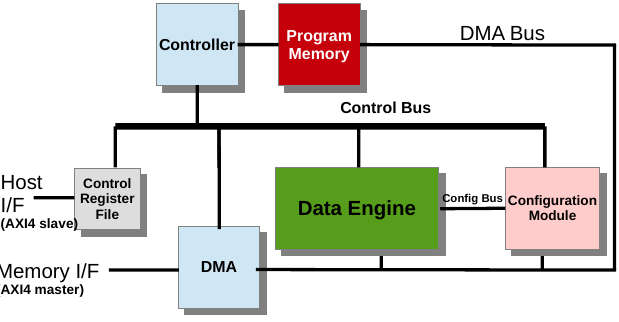
Figure 1. Versat top-level entity.